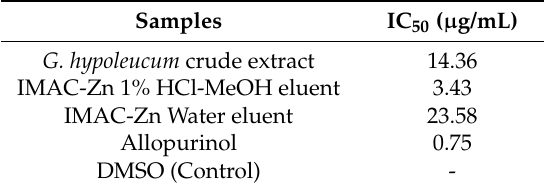
Table 1. Inhibitory effect of samples and allopurinol on XOD activity in